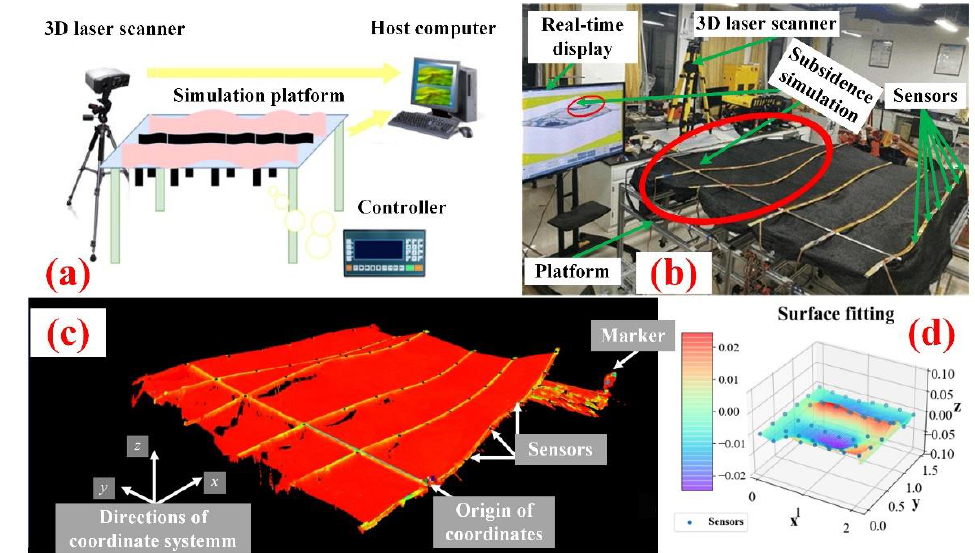
Figure 13. ( a ) Platform schematic; ( b ) Subsidence simulation experiment; ( c ) Surface in 3D laser scanner ( d ) Reconstructed surface. Table 2. Simulation experiment statistics. Shape 1 Shape